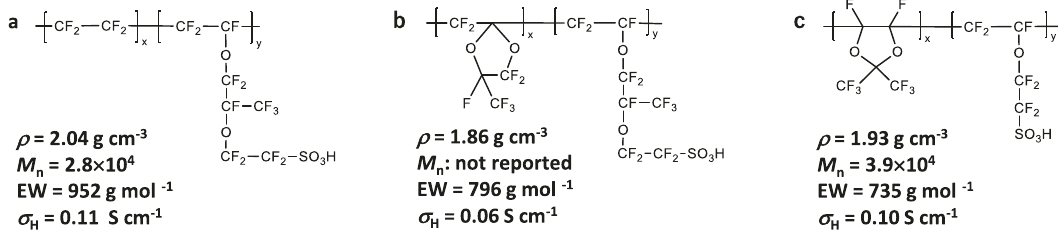
Fig. 2 Molecular structures of ionomers. a – c Molecular structures of Na fi on ionomer ( a ), HOPI with PFMMD matrix reported in ref. 41 ( b ), and HOPI synthesized in this work ( c ). Density ( ρ ), number-average molecular weight ( M n ), EW (ionomer mass per sulfonate group), and proton conductivity ( σ H ) are also shown. The density was measured under dry conditions, and the proton conductivity shown here was obtained at 97% RH and